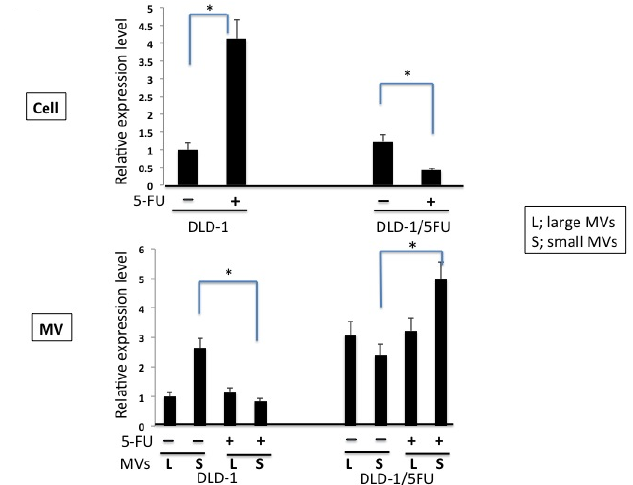
Figure 3. Detection of miR-145 levels in DLD-1 and DLD-1/5FU cells and in their MVs. Levels of miR-145 in the cells (the upper panel) and in their MVs (the lower panel) trapped by the 1st (L) and 2nd (S) filters of the ExoMir kit. The upper panel shows the relative expression of miRNA in the cells before and after the treatment with 5-FU (10 µM) for 48 h; and the relative quantities are given relative to the amount in DLD-1 cells indicated as “1”, as in the case of MVs. The results are presented as the average value of three independent experiments. MV(L) and MV(S) were MVs filtered through 1st filter and 2nd filter, respectively, of the ExoMir kit. “+”: treatment with 5-FU; “ − ”: treatment with DMSO alone. * p < 0.05 is considered to be significant.